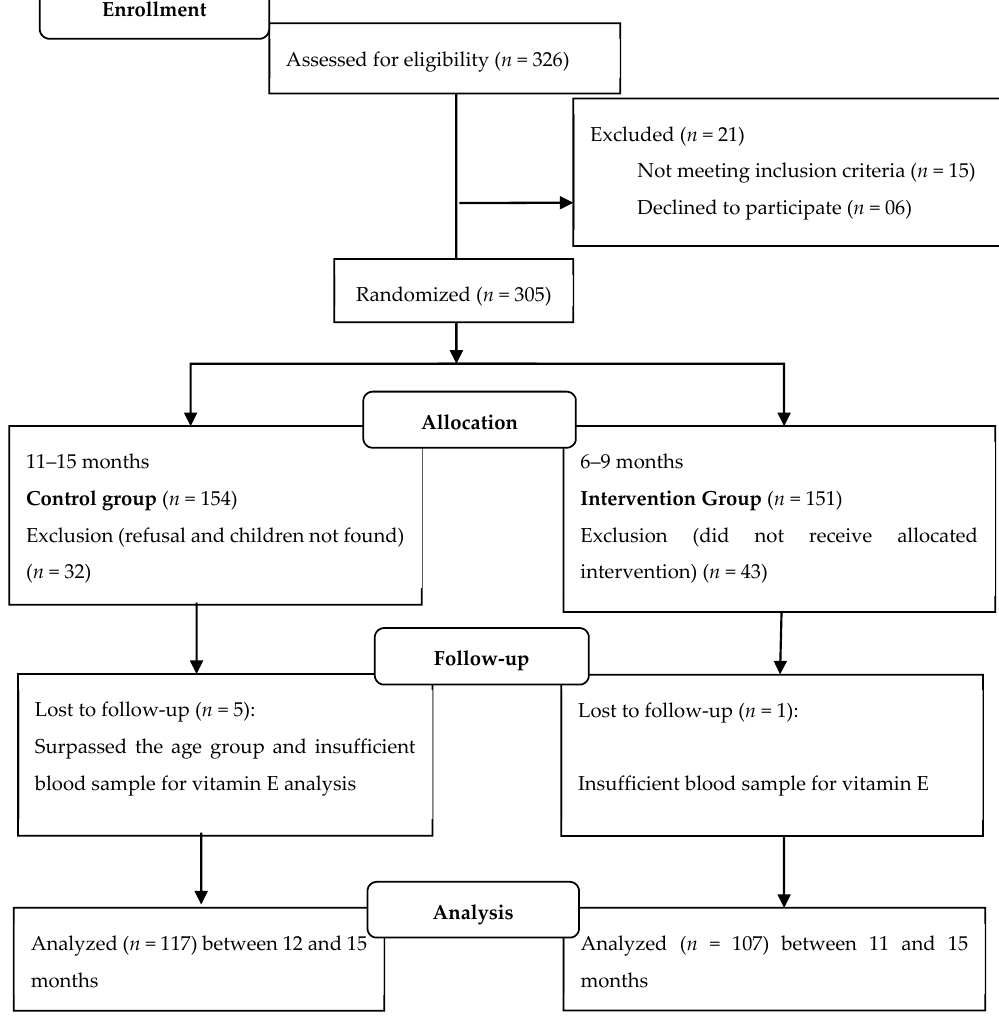
Figure 1. Outline of the matrix project study.